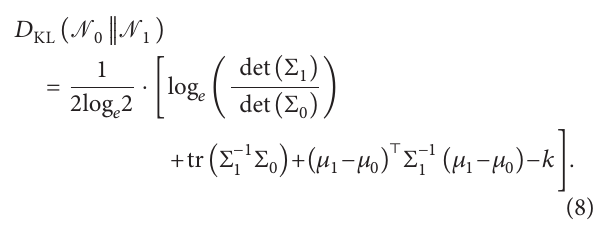
distributions 𝑃 and 𝑄 , it is possible to apply some form of